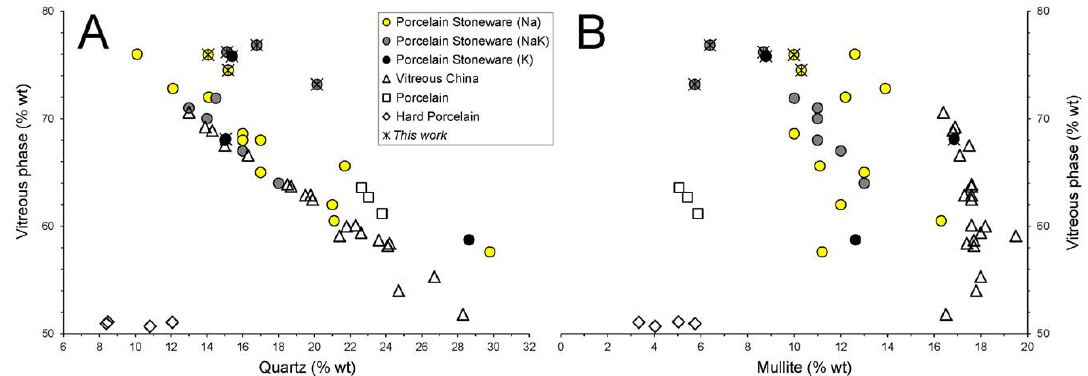
Figure 3. Phase composition of porcelain stoneware bodies compared with other porcelain-like materials: amount of vitreous phase versus quartz ( A ) and mullite ( B ).